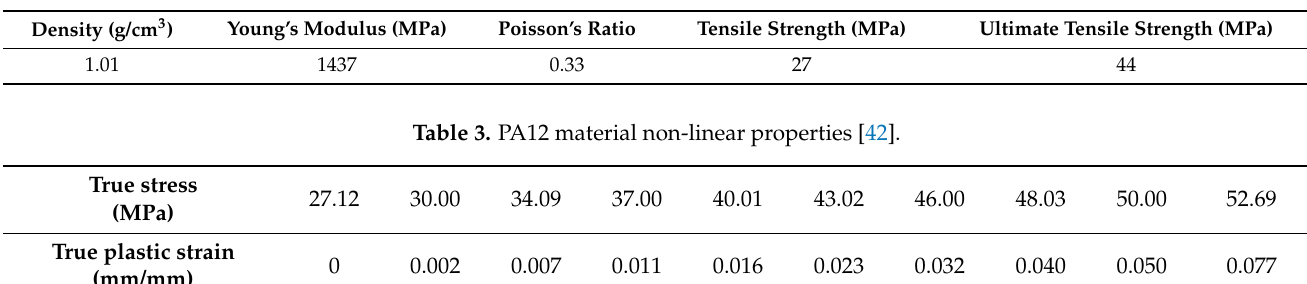
Table 2. PA 12 material linear properties [42].